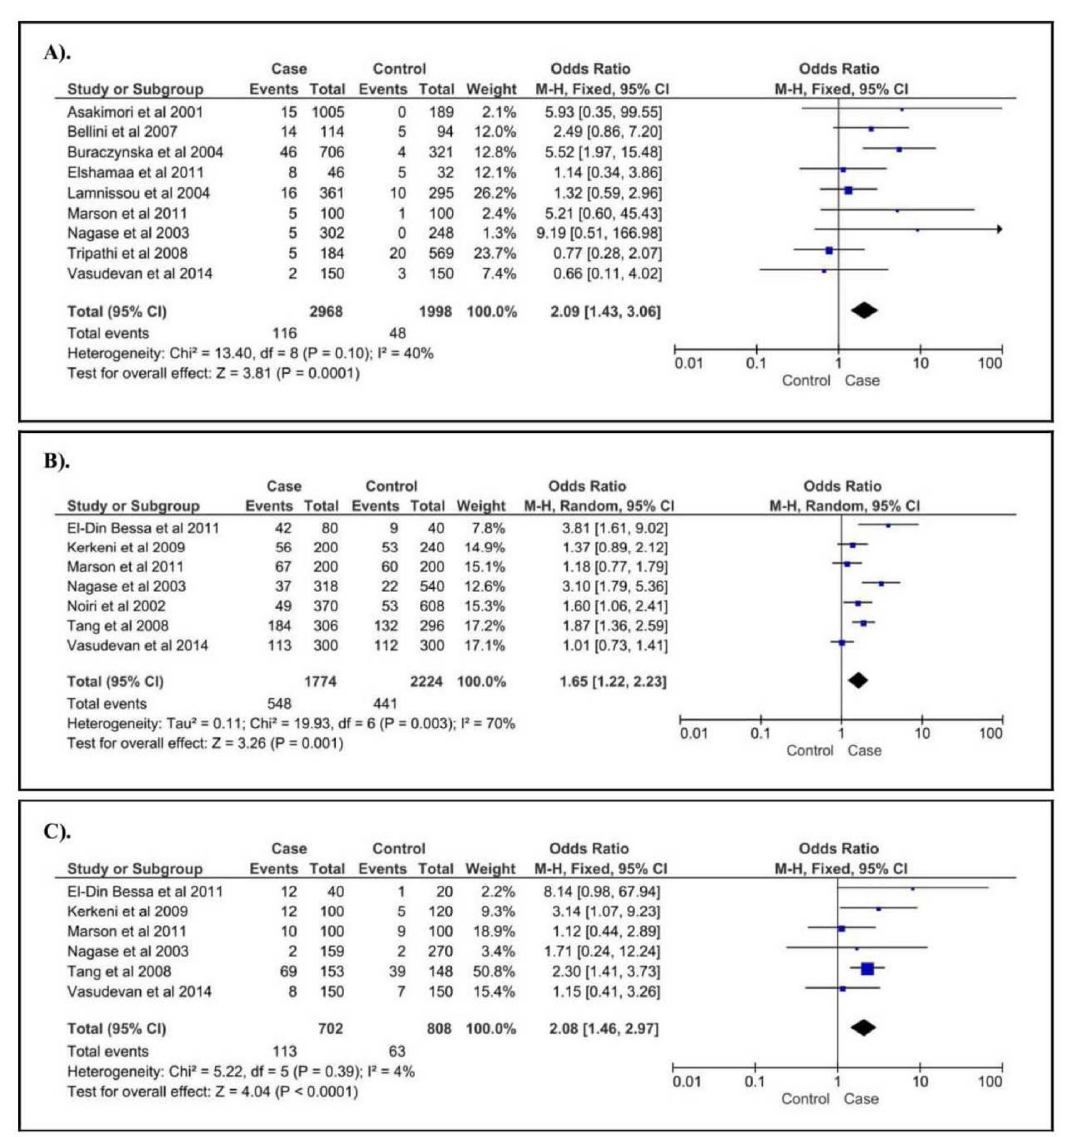
Figure 3. Forest plot of the association between NOS3 gene polymorphism and the risk of CKD. A ). 4a4a vs. 4b4b+4b4a of NOS3 4b/4a; B ). T vs. G of NOS3 G-894T; C ). TT vs. GG+GT of NOS3 G-894T.